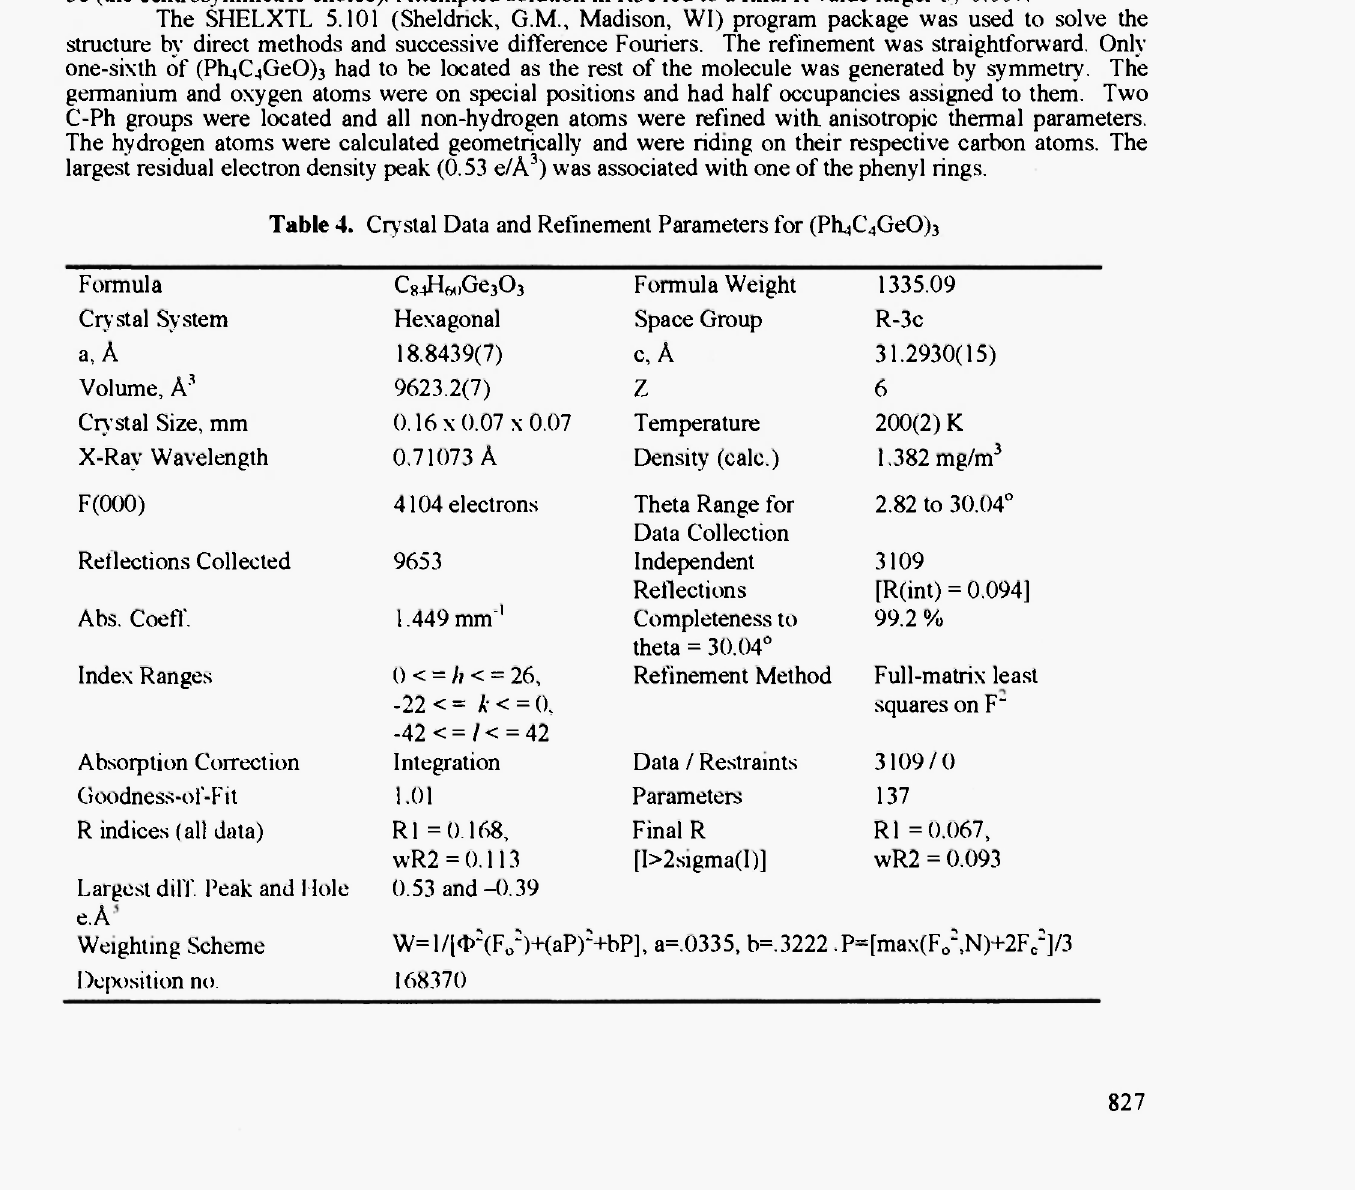
Table 4. Systematic absences implied either R-3c or R3c. Ε-statistics and successful solution confirmed R- 3c (the centrosymmetric choice). Attempted solution in R3c led to a final R value larger by 0.007. The SHELXTL 5.101 (Sheldrick, G.M., Madison, WI) program package was used to solve the structure by direct methods and successive difference Fouriers. The refinement was straightforward. Only one-sixth of (Ph4C 4 GeO) 3 had to be located as the rest of the molecule was generated by symmetry. Thie germanium and oxygen atoms were on special positions and had half occupancies assigned to them. Two C-Ph groups were located and all non-hydrogen atoms were refined with anisotropic thermal parameters. The hydrogen atoms were calculated geometrically and were riding on their respective carbon atoms. The